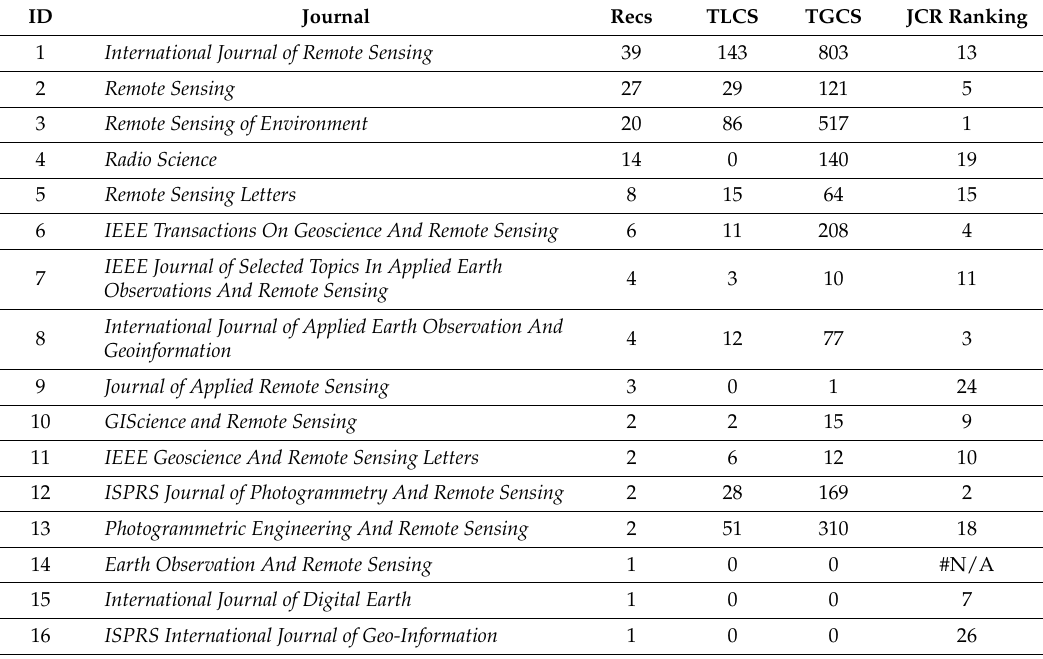
Table 1. Journals publishing papers on the NTL remote